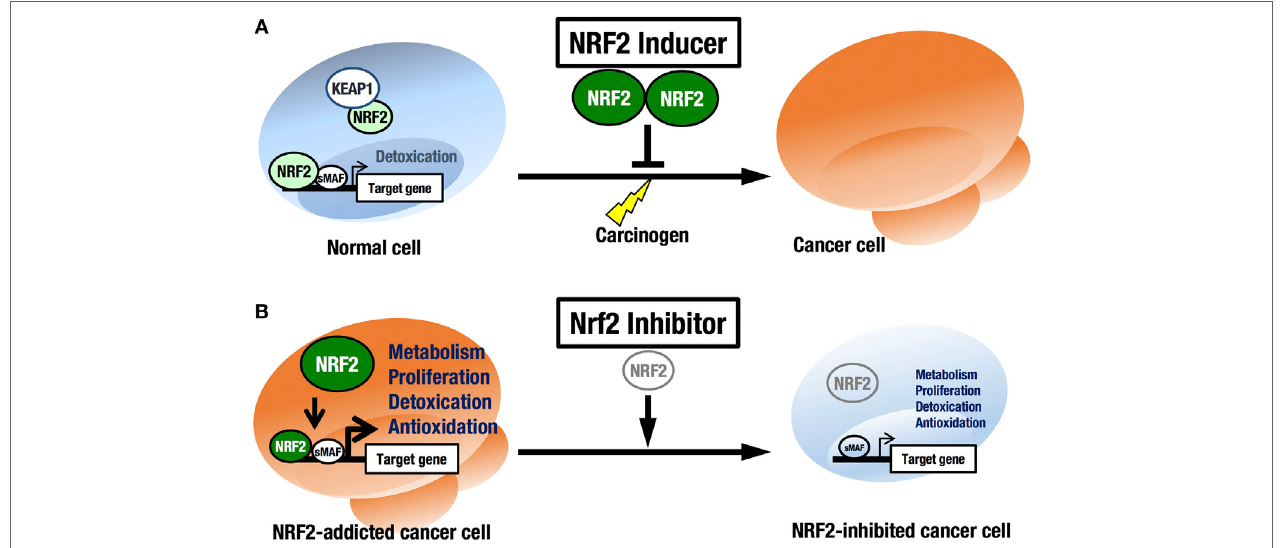
FigURe 5 | Two strategies for cancer therapy focused on NRF2 . (A) Chemoprevention against carcinogens by NRF2 inducers in normal cells. (B) Anticancer therapy against NRF2-addicted cancer cells by NRF2